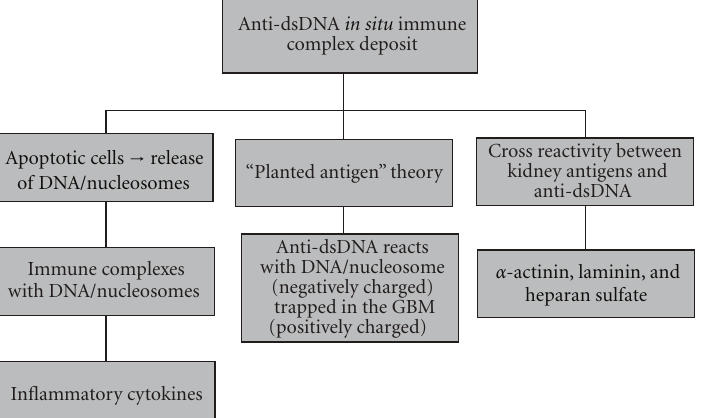
Figure 2: Proposed theories for anti-dsDNA in situ immune complex deposit [13]. GBM: glomerular base